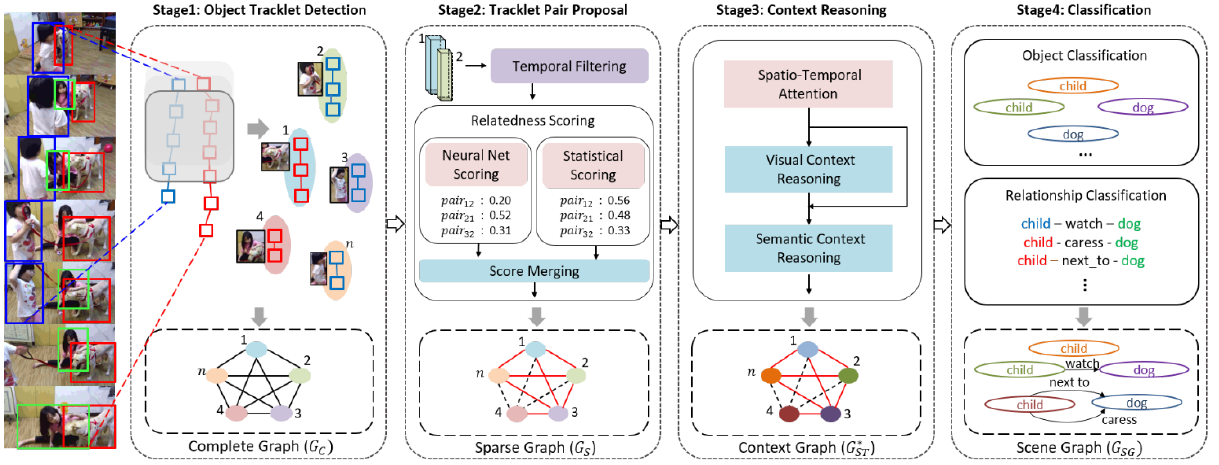
Figure 2. The proposed model for video scene graph generation.